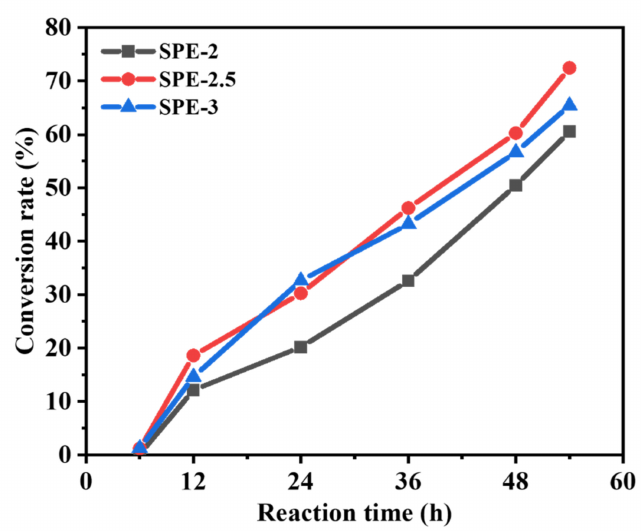
Figure 3. Conversion rate vs. reaction time plots of SPE-2, SPE-2.5, and